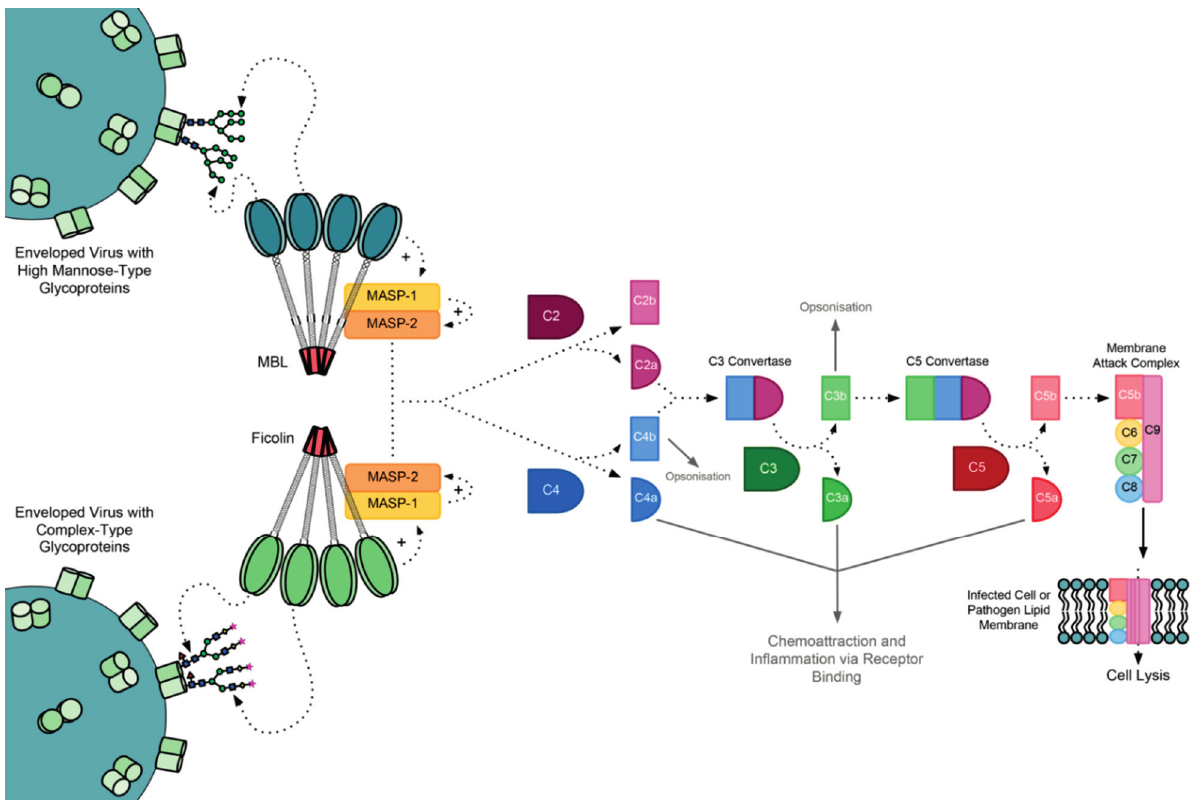
Figure 1. The lectin pathway of complement activation. MBL and ficolins undergo conformational changes upon interaction with viral glycoproteins via glycan-associated mannose and N -acetylglucosamine residues, respectively. Sugars are labelled in accordance with reference [7]. This activates MASP-1 followed by MASP-2, which initiates a cleavage cascade of complement factors, with roles in opsonisation, inflammation and pathogen and infected cell